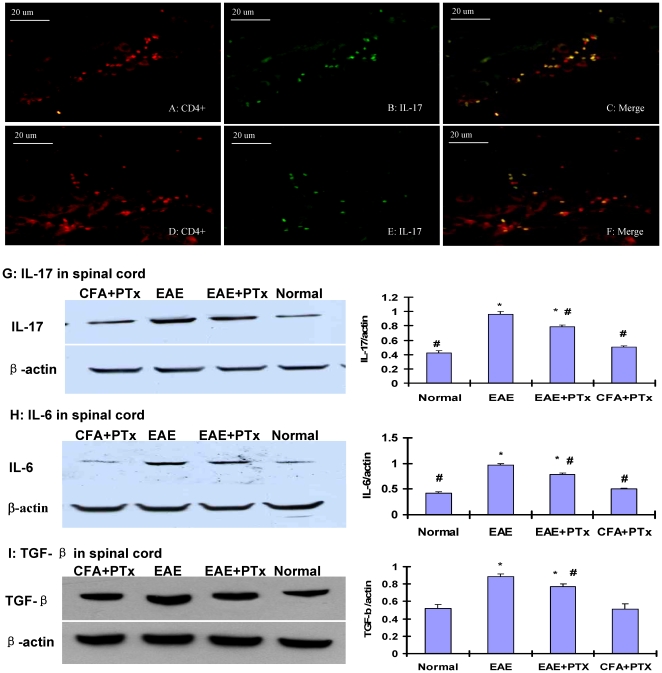
Inflammatory cytokines and cells in the spinal cord of EAE and EAE +PTx icv mice (n = 6/group).IL-17+/CD4+ cells were detected in the meninges of the spinal cord in the EAE +PTx icv mice (A–C), whereas these cells were diffusely identified in the spinal parenchyma in the EAE mice (D–F). Original magnification ×400. The western blot depicts measures of IL-17 (G), IL-6 (H) and TGF-β (I). In the spinal cord, elevated levels of all three were identified in the EAE mice relative to the EAE +PTx icv mice. Statistical evaluation of optic density (OD) normalized to β-actin was obtained. Mean ± SD are depicted (n = 6 per group). *P<0.05, compared with normal control group; #P<0.05, compared with EAE group.